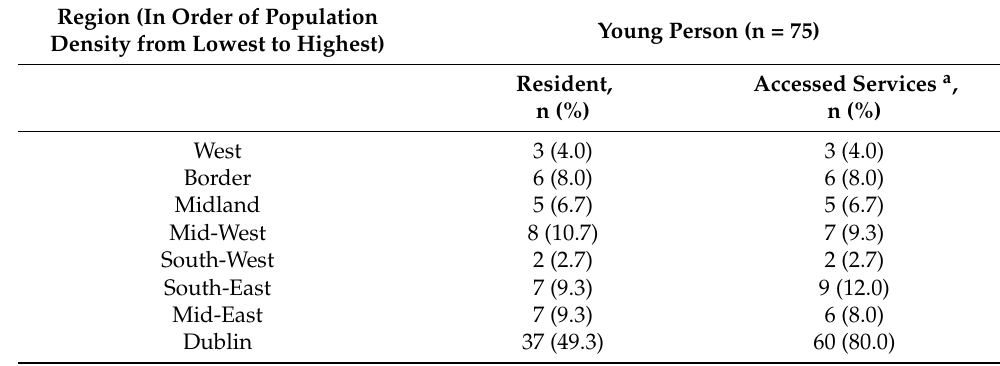
Table 2. Regions of Ireland in which young people resided and accessed